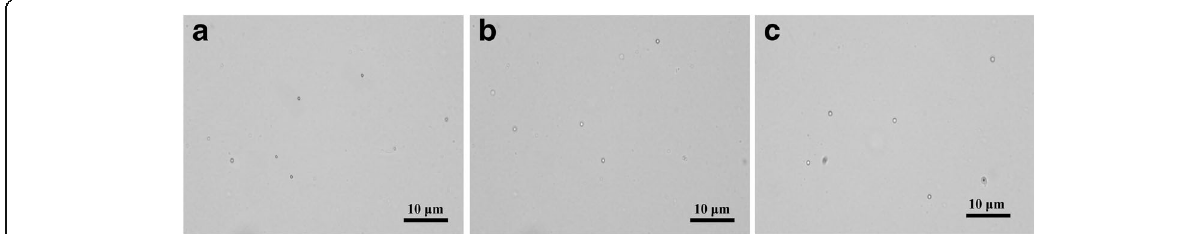
Fig. 3 Optical images of DOX-NBs a at room temperature, b after 6 h at 25 °C in PBS, and c after 6 h at 25 °C in the serum